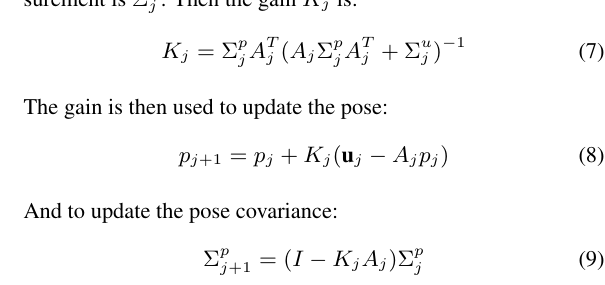
Figure 2: (a) One of the reference GPS images; (b) Correspond- ing distance matrix: each pixel is coloured as a function of its distance to the camera (in